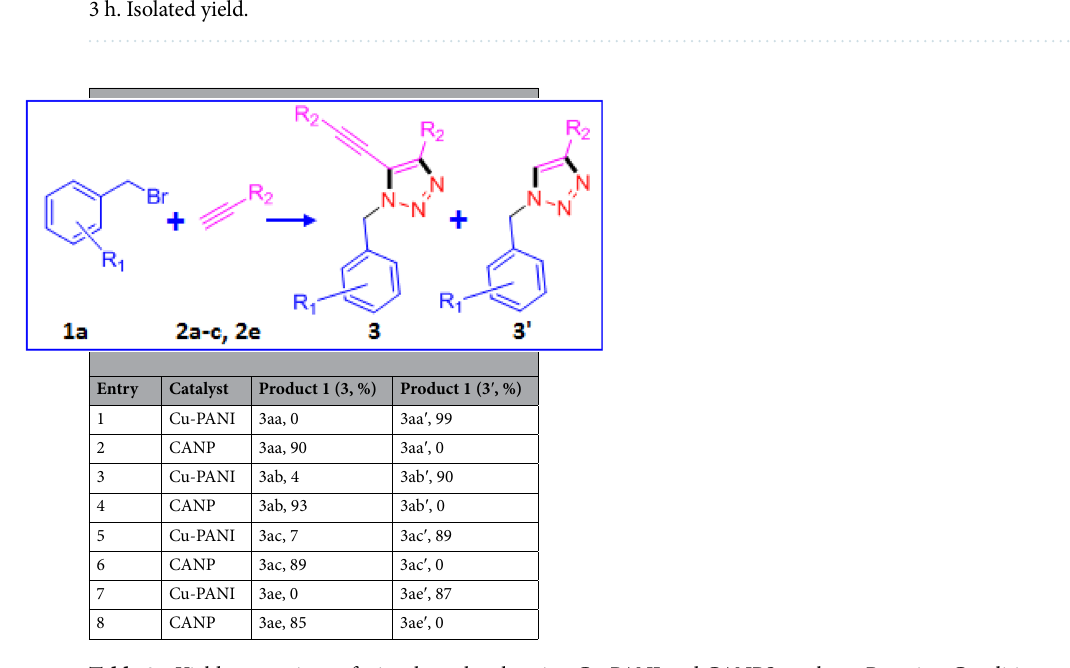
Table 3. Yield comparison of triazole molecule using Cu-PANI and CANPS catalysts. Reaction Conditions: Benzyl bromide (171 mg, 1.0 mmol), 4-ethynyl-1-fluoro-2-methylbenzene, MeOH (4.0 mL), Cu-PANI/CANP (200 mg, 1 equivalent), 3 h. Isolated